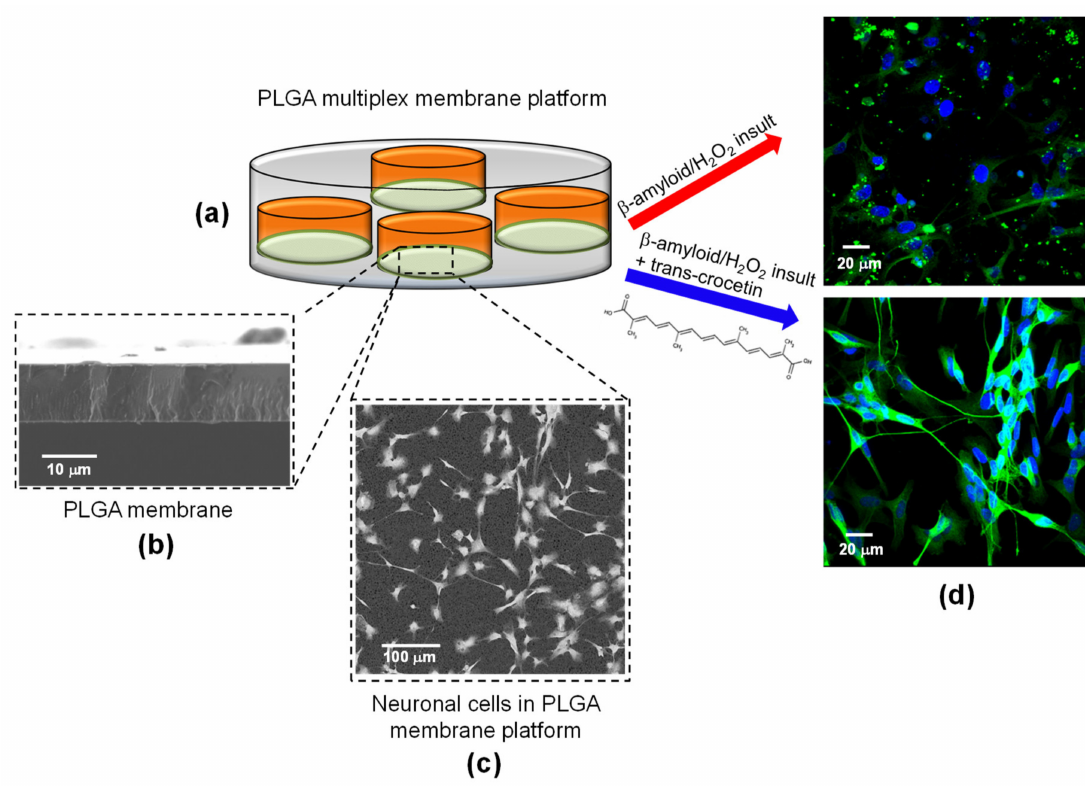
Figure 1. Schematic illustration of the experimental setup: ( a ) Poly(D,L-lactide-co-glycolide) (PLGA) multiplex membrane platform; ( b ) cross section of PLGA membrane; ( c ) Scanning electron microscopy (SEM) image of neurons after 7 days in PLGA membrane platform; ( d ) confocal images of neurons after toxic insult induced with amyloid-beta (A β ) or H 2 O 2 treatment (red arrow), and trans-crocetin administration (blue arrow). Cells were stained for neuronal marker β III-tubulin (green) and cell nuclei marker (DAPI,